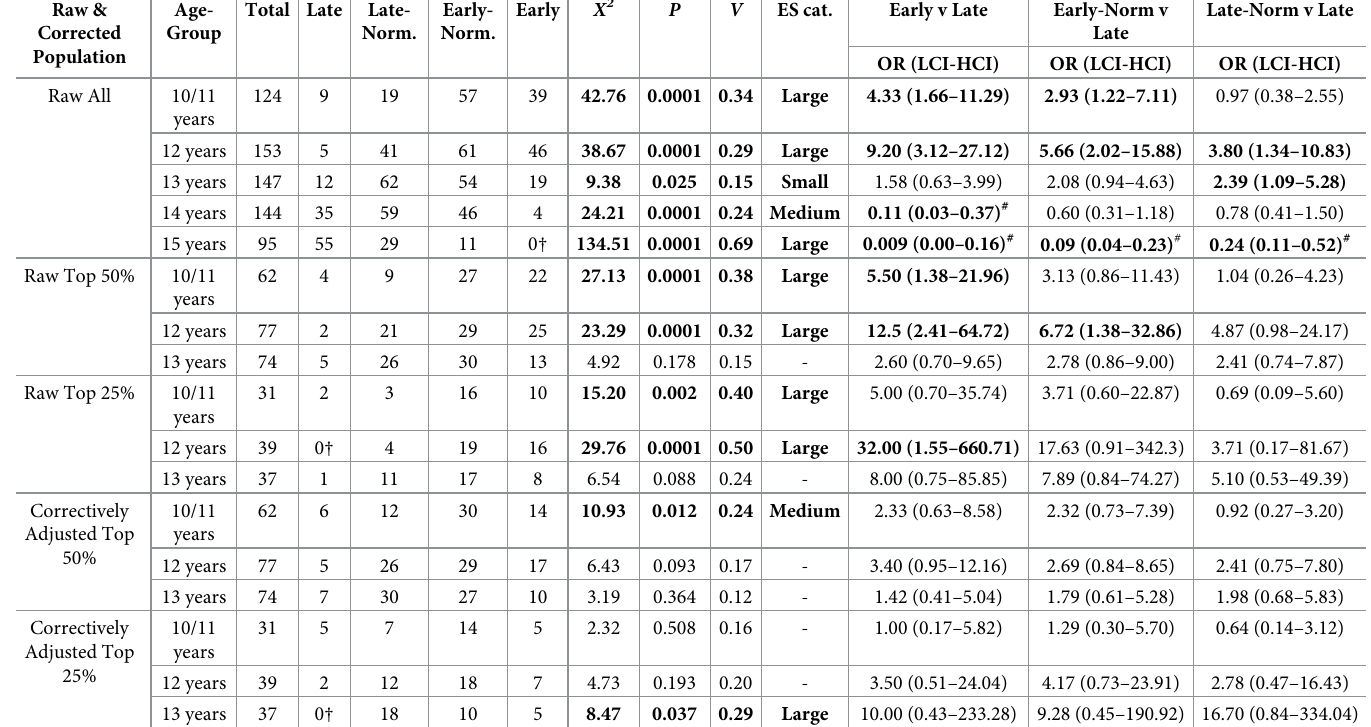
Table 2. Revised maturity timing distributions, chi-square, and odds ratio analyses of 424 female swimmers (10/11-13 years) according to raw ‘All’, ‘Top 50%’ and ‘Top 25%’, and correctively adjusted ‘Top 50%’ and ‘Top 25%’ of swim